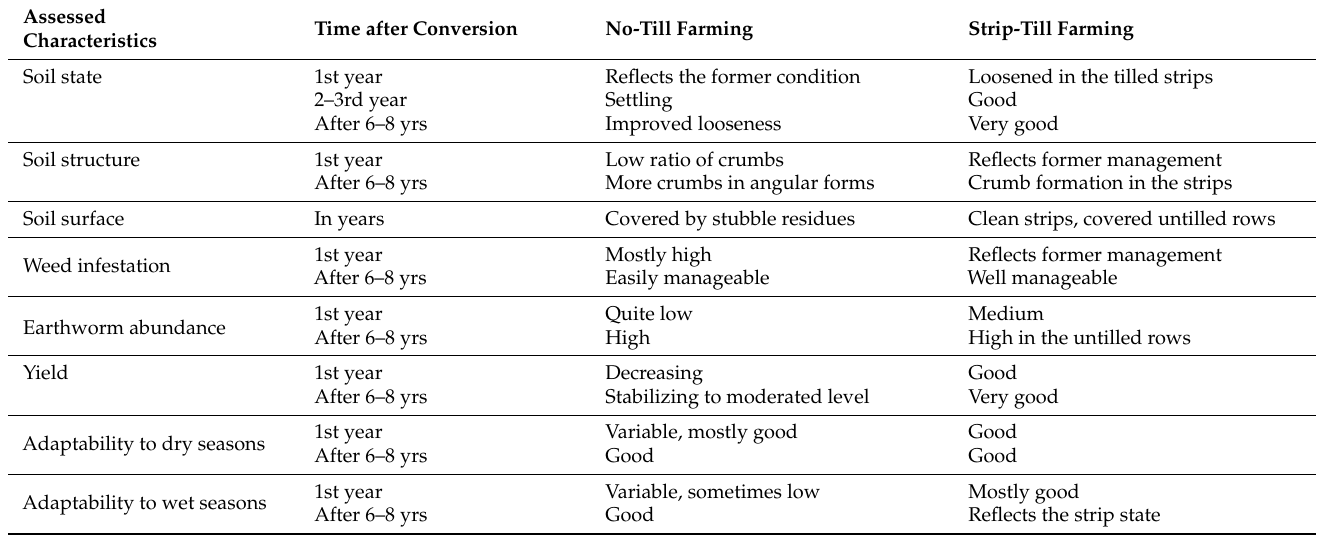
Table 1. Evaluation of no-till and strip-till farming in the first years and in the long term based on Birk á s [17].